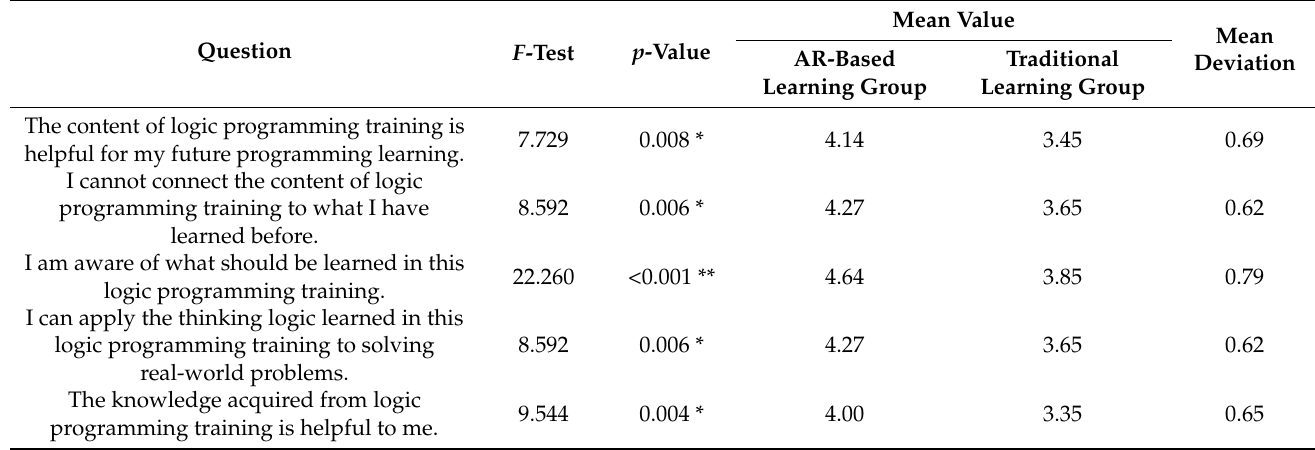
Table 10. Level of significance for each question in the Relevance